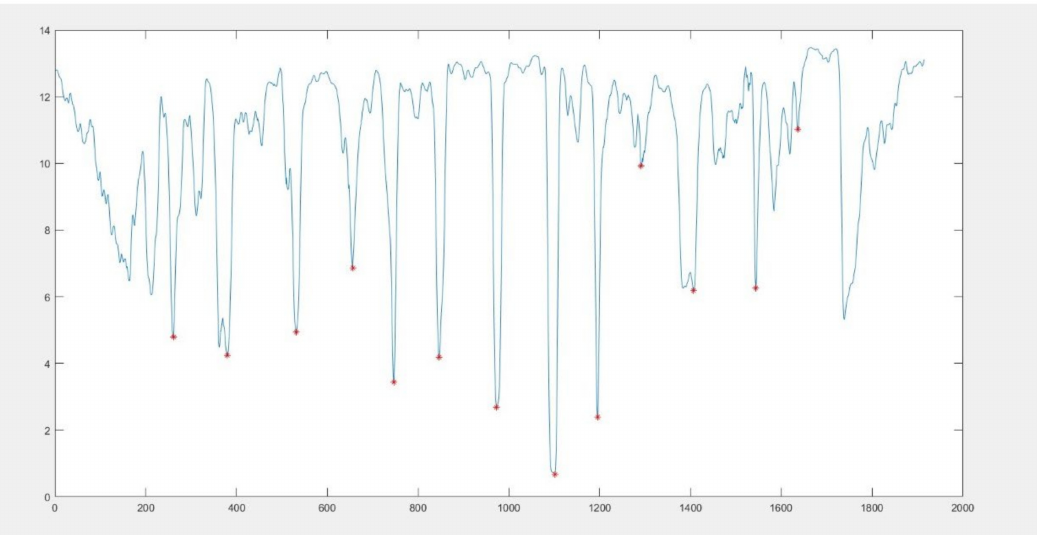
and the pixel values of each point are represented by a line chart, with the position of the tooth seam becoming a local minimum value. Poonsri et al. [16] proposed the fixed range